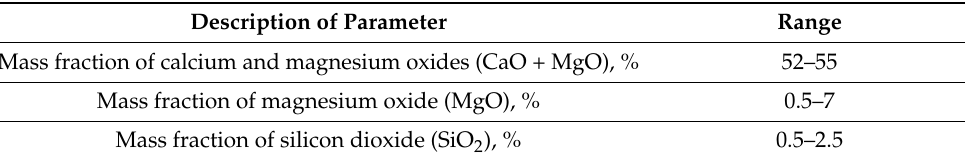
Table 1. The standard chemical composition of limestone.